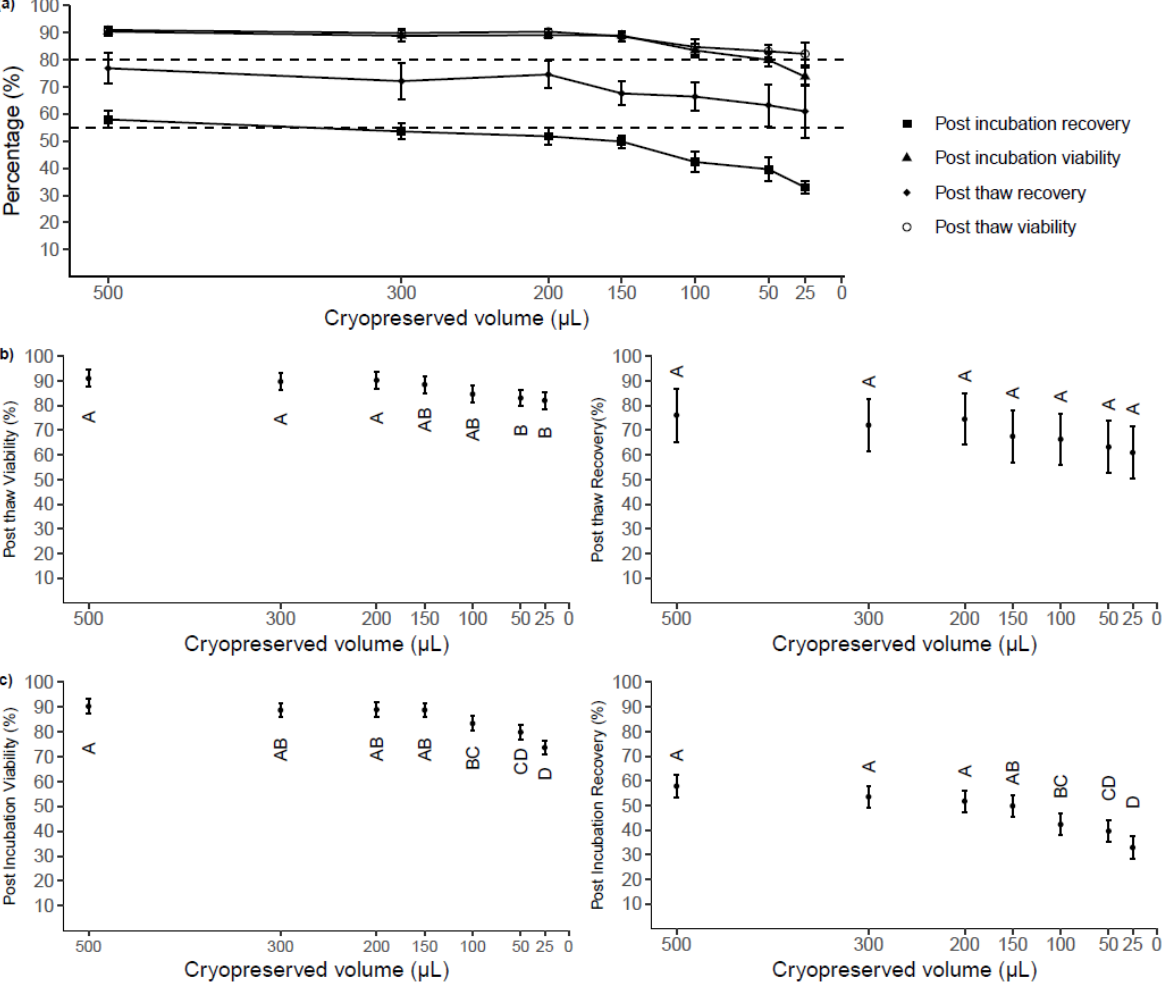
Figure 3. ( a ) Post-thaw and post-incubation viability and recovery from samples stored at a cell density of 10 × 10 6 cells/mL at seven different volumes. Each point represents the mean of raw data with SD (n = 3). Acceptable criteria: Post-thaw viability ≥ 80%, post-thaw recovery ≥ 55% ( b ) The impacts of cryoprotectant media volume on post-thaw viability (predicted mean with 95% CI, n = 3). ( c ) The impacts of cryoprotectant media volume on viability measured post-overnight incubation at 37 ◦ C (predicted mean with 95% CI, n = 3). Letters (A, B, C, D) indicate groups (Tukey’s test), where predicted means that are not significantly different are labeled with the same